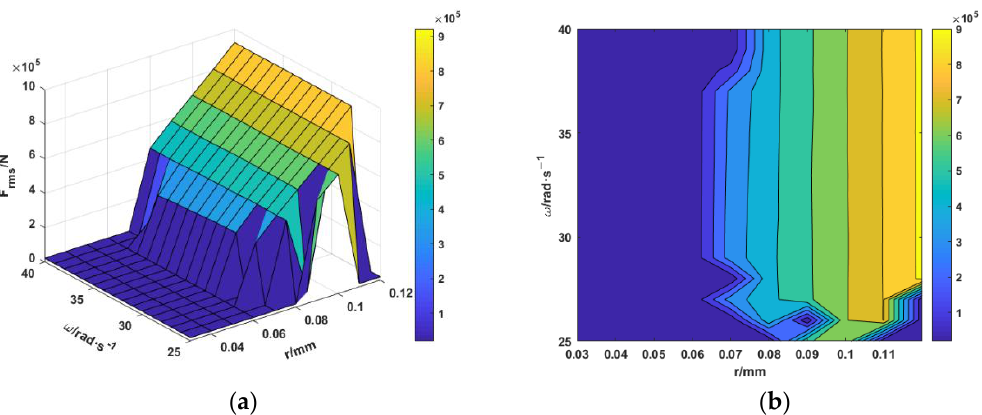
Figure 14. Root-mean-square values of the vibration force on the foundation: ( a ) 𝑟 − 𝜔 − 𝐹 𝑟𝑚𝑠 three-dimensional surface diagram; ( b ) 𝑟 − 𝜔 − 𝐹 𝑟𝑚𝑠 contour map.